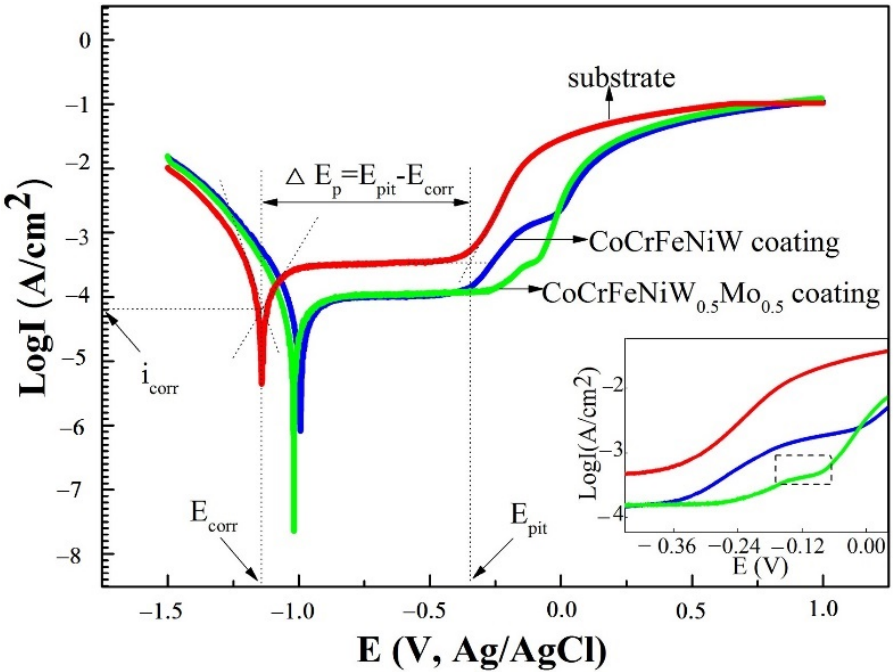
Figure 16. Potentiodynamic polarisation curves for the Q235 steel and vacuum hot pressing sintered-HEA coatings in 3.5% NaCl solution. Reprinted with permission from [165] Copyright 2016 Elsevier .